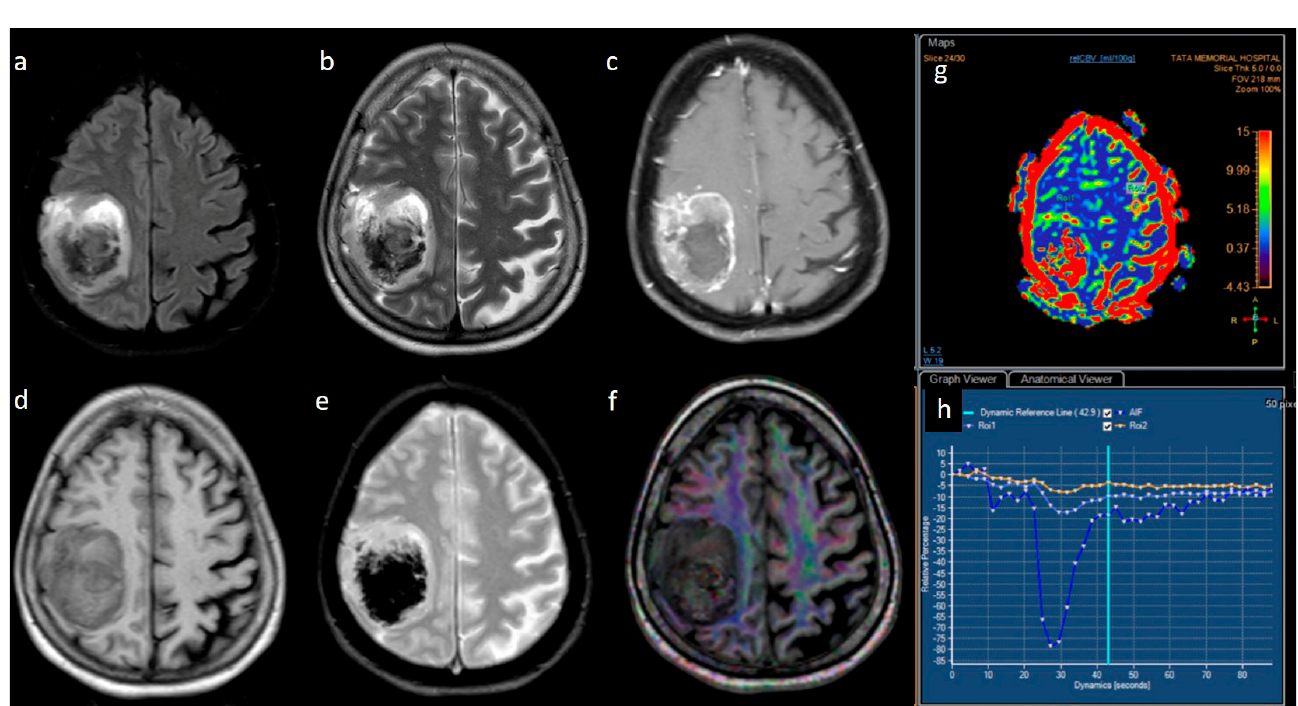
Figure 1. ( a − h ) FLAIR, T1, T2, post-contrast T1, perfusion color map, and graph representative of IDH-mutant grade 4 astrocytoma. Images a − d show a homogenous well-circumscribed mass with- out necrosis and edema less than the tumor volume. Images e − h are dynamic susceptibility contrast images showing hypoperfusion.